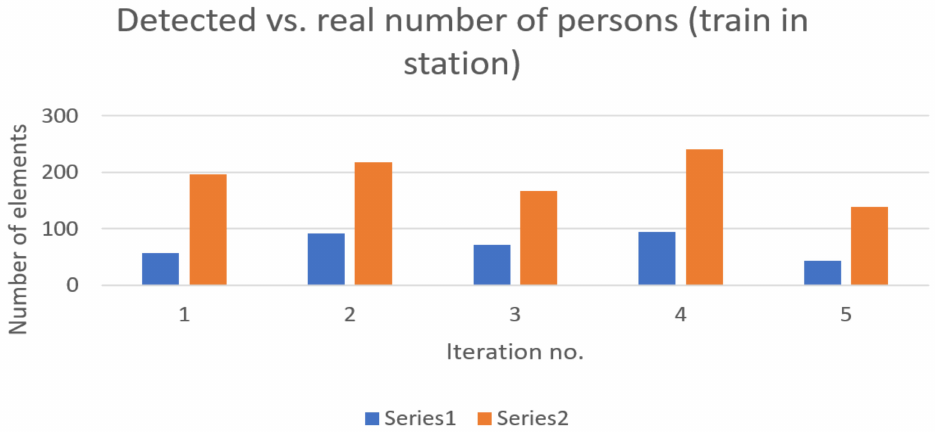
Figure 5. Detected devices (represented in blue—Series 1) versus real number of persons (represented in orange—Series 2) present on platforms—one train in station (Subway Station 1).